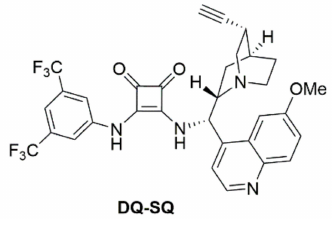
Figure 8. Structure of